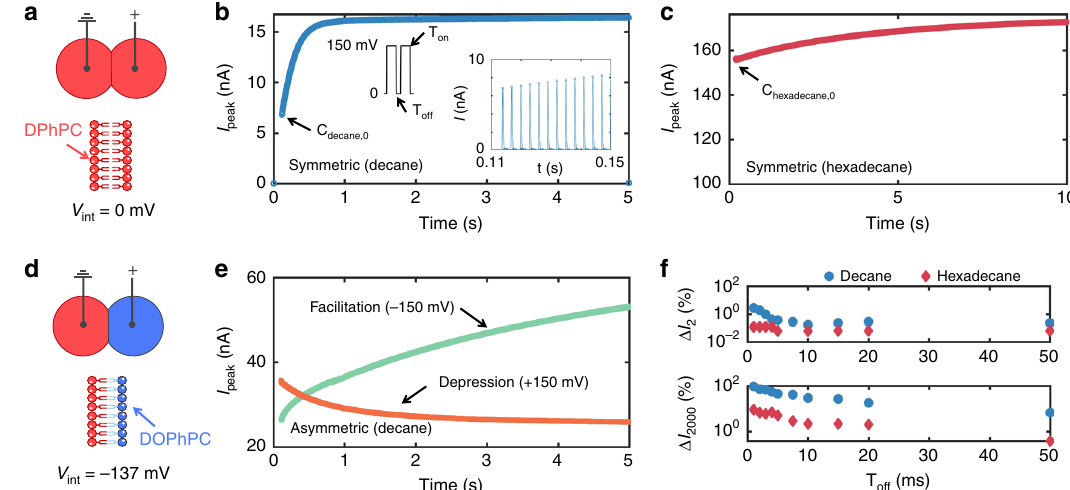
Fig. 5 Short-term synaptic facilitation and depression achieved via recon fi gurable capacitor geometry. a A schematic showing a symmetric bilayer with zero intrinsic bias consisting of DPhPC lipids in both lea fl ets. b Demonstration of short-term facilitation of capacitive current measured for a symmetric DPhPC bilayer in decane at RT. Facilitation and depression are forms of short-term plasticity found in the presynaptic terminal 54 evoked by successive voltage stimuli. For this measurement, a series of 150 mV pulses with 2 ms ON-time ( T on ) and 0 mV, 1 ms OFF-time ( T off ) caused an accumulated, monotonic increase in peak capacitive current output due to the dynamic, history-dependent increase in membrane capacitance. The inset shows individual capacitive spikes induced by the rising edges of voltage pulses (we are not displaying the negative spikes; Supplementary Fig. 13 provides bipolar responses). c Peak capacitive current versus time shows facilitation for a bilayer in hexadecane at RT for the same voltage input as in ( b ). d An asymmetric membrane with an intrinsic bias of − 137 mV due to the difference in lipid dipole potentials is created by joining one DPhPC-coated droplet and one DOPhPC-coated droplet. e Demonstration of short-term depression in peak capacitive current due to a reduction in net membrane potential in response to the same voltage pulses as in ( b ). Changing to negative pulses increases the net membrane potential v m ¼ (cid:2) v (cid:2) 137 mV ð Þ , which leads to EW and EC increasing the capacitance of the interface, and results in facilitation in peak current versus time. f Percentage increases in measured peak current relative to the fi rst pulse response for the 2nd ( Δ I 2 ) and 2000th ( Δ I 2000 ) voltage pulses at various T off values for a symmetric DPhPC membrane in decane at RT